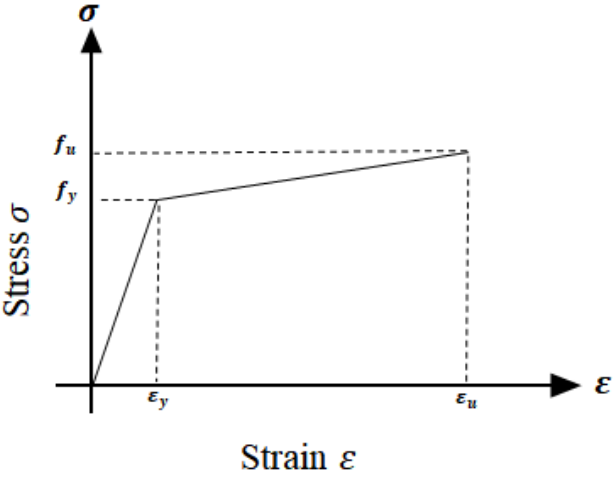
Figure 2. Uniaxial stress–strain relationship of the steel